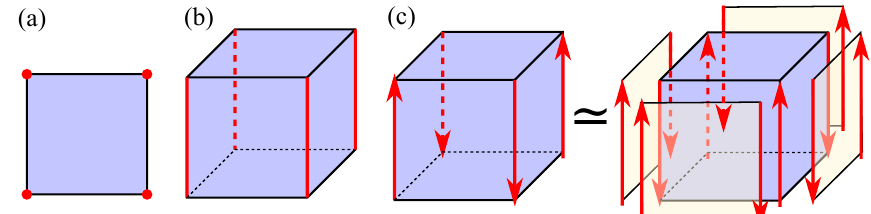
Figure 3: Examples of strong topological phases protected by a fourfold rotation symmetry: (a) with Majorana corner states in two dimensions, and (b) with helical hinge modes in three dimensions. In (c), a three-dimensional insulator with chi- ral hinge modes consistent with a magnetic rotation symmetry C symmetry-allowed decoration as indicated changes the propagation direction of the chiral modes after